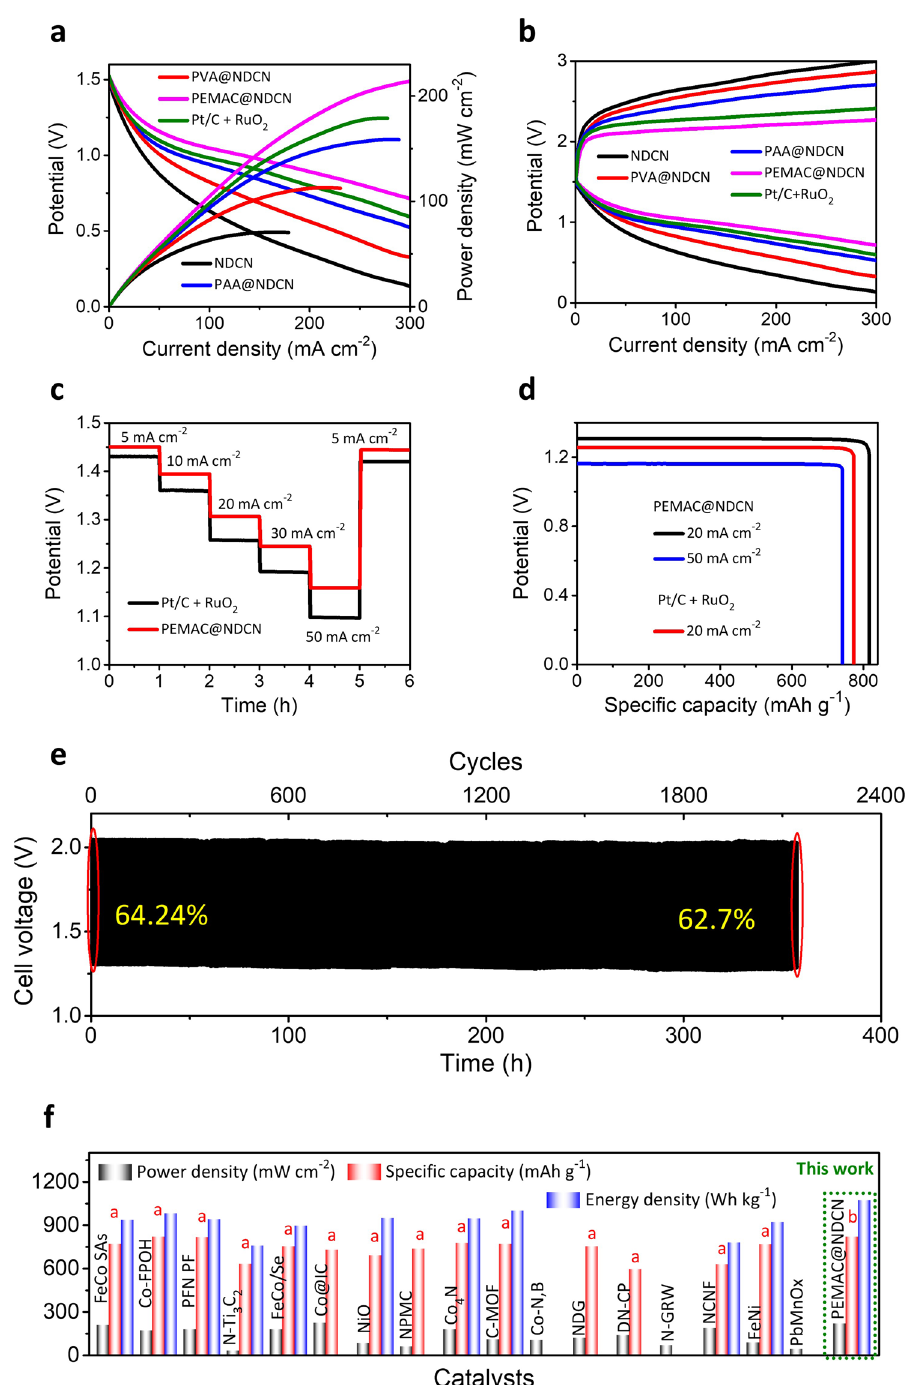
Fig. 8 Electrochemical performances for alkaline Zn–air batteries. a Power densities and galvanostatic discharge voltage polarizations for ZABs with PEMAC@NDCN, PVA@NDCN, PAA@NDCN, and NDCN cathodes relative to those of Pt/C + RuO 2 reference materials. b Discharge and charge voltage measurements for PEMAC@NDCN relative to those of Pt/C + RuO 2 reference materials. c Rate capacity measurements for PEMAC@NDCN compared to those of Pt/C + RuO 2 reference materials from 5 to 50 mA cm −2 . d Evaluated capacities and energy densities for PEMAC@NDCN // KOH // Zn and Pt/C + RuO 2 // KOH // Zn cells. e Galvanostatic cycle life evaluations for PEMAC@NDCN // KOH // Zn cells for the current rate of 20 mA cm −2 (Time: 10 min per cycle). Displayed percent values are the voltaic efficiencies. f Ragone plot presents the projections of capacities and power densities of designed PEMAC@NDCN // KOH // Zn cells in comparison with previously reported cham‑ pion ZABs. (Conditions: cathode‑ PEMAC free‑standing air cathode, electrolyte‑6 M KOH + 0.2 M Zn acetate, and anode‑Zn